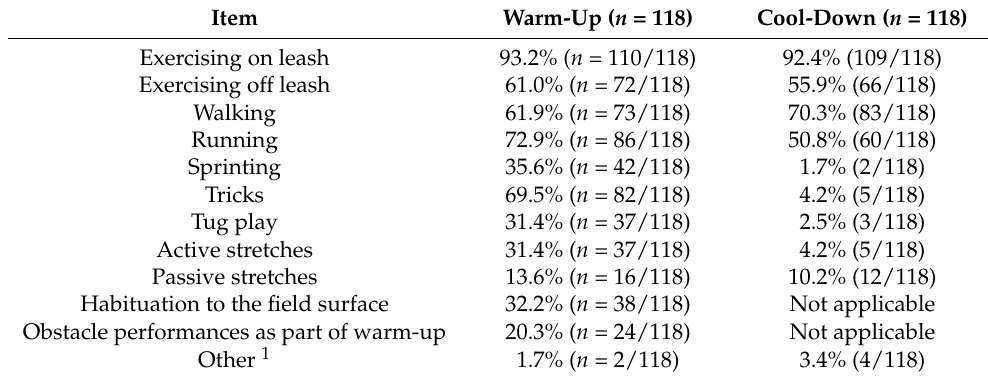
Table 8. Elements of a usual warm-up and cool-down.